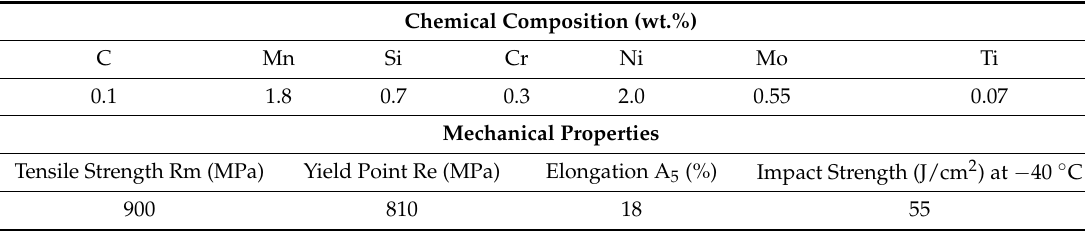
Table 4. Chemical composition and mechanical properties of filler metal GMn4Ni1.5CrMo. Chemical Composition